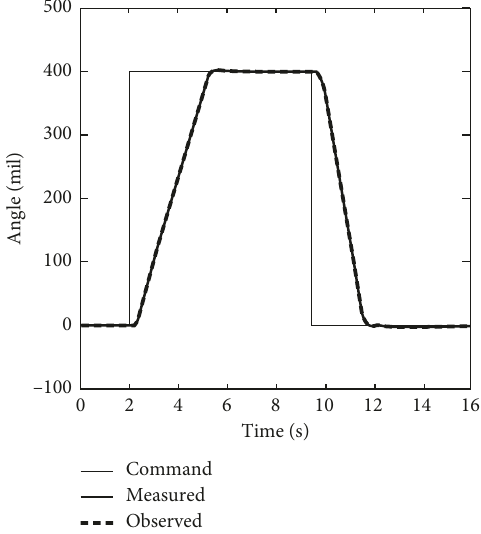
Figure 3: Elevating angle.